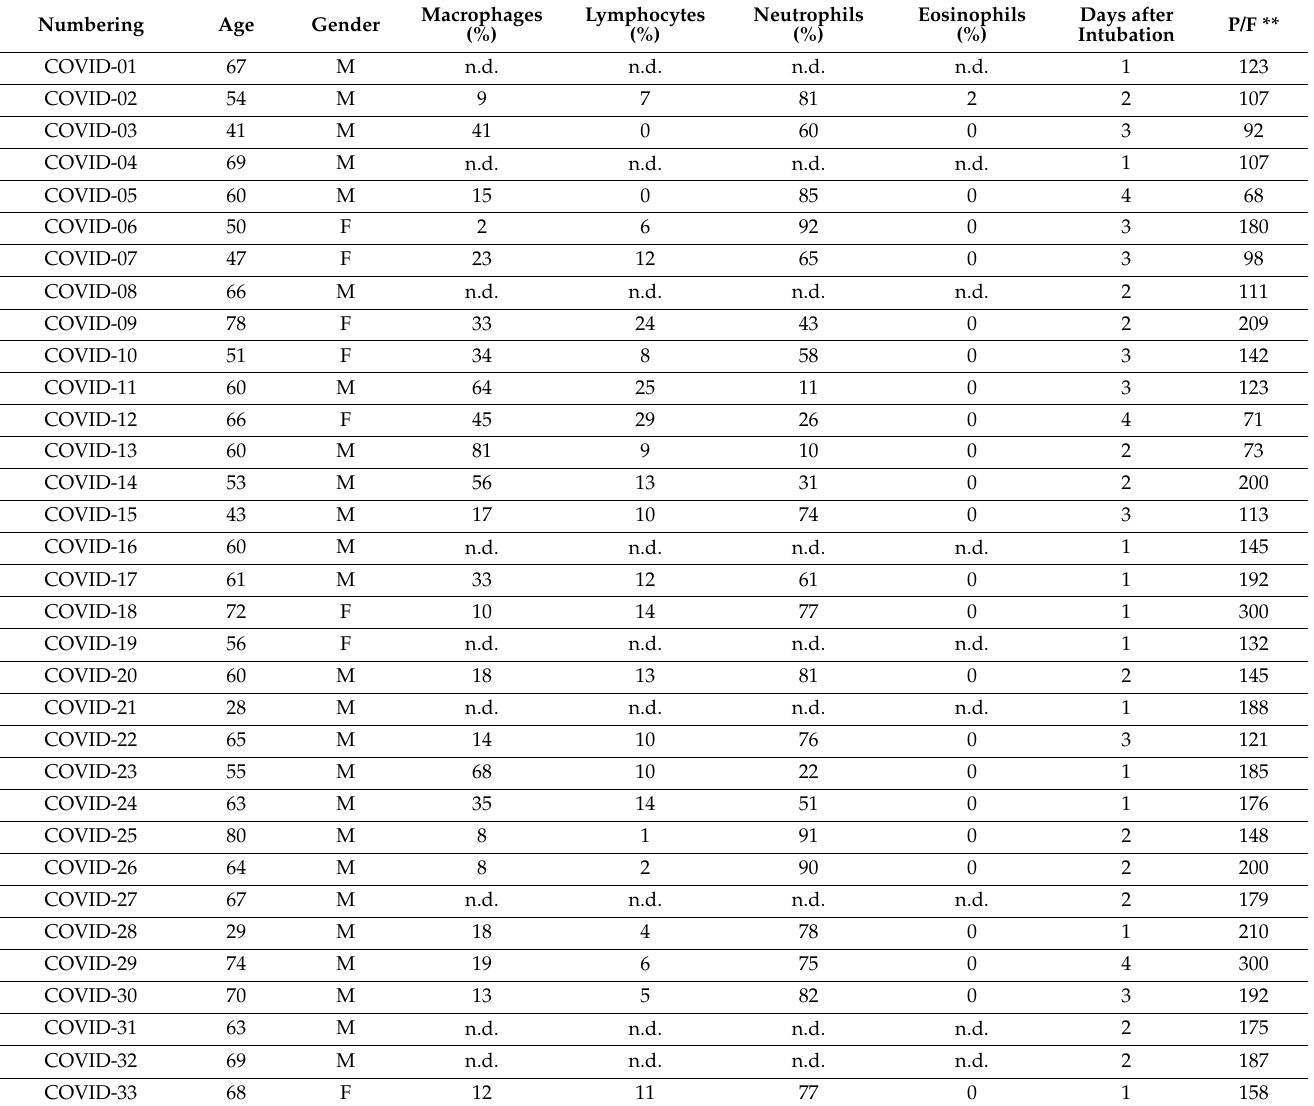
Table 1. Demographic and clinical features (including age, gender, % of macrophages, lymphocytes, neutrophils, eosinophils, days after incubation and P/F) of patients considered in this